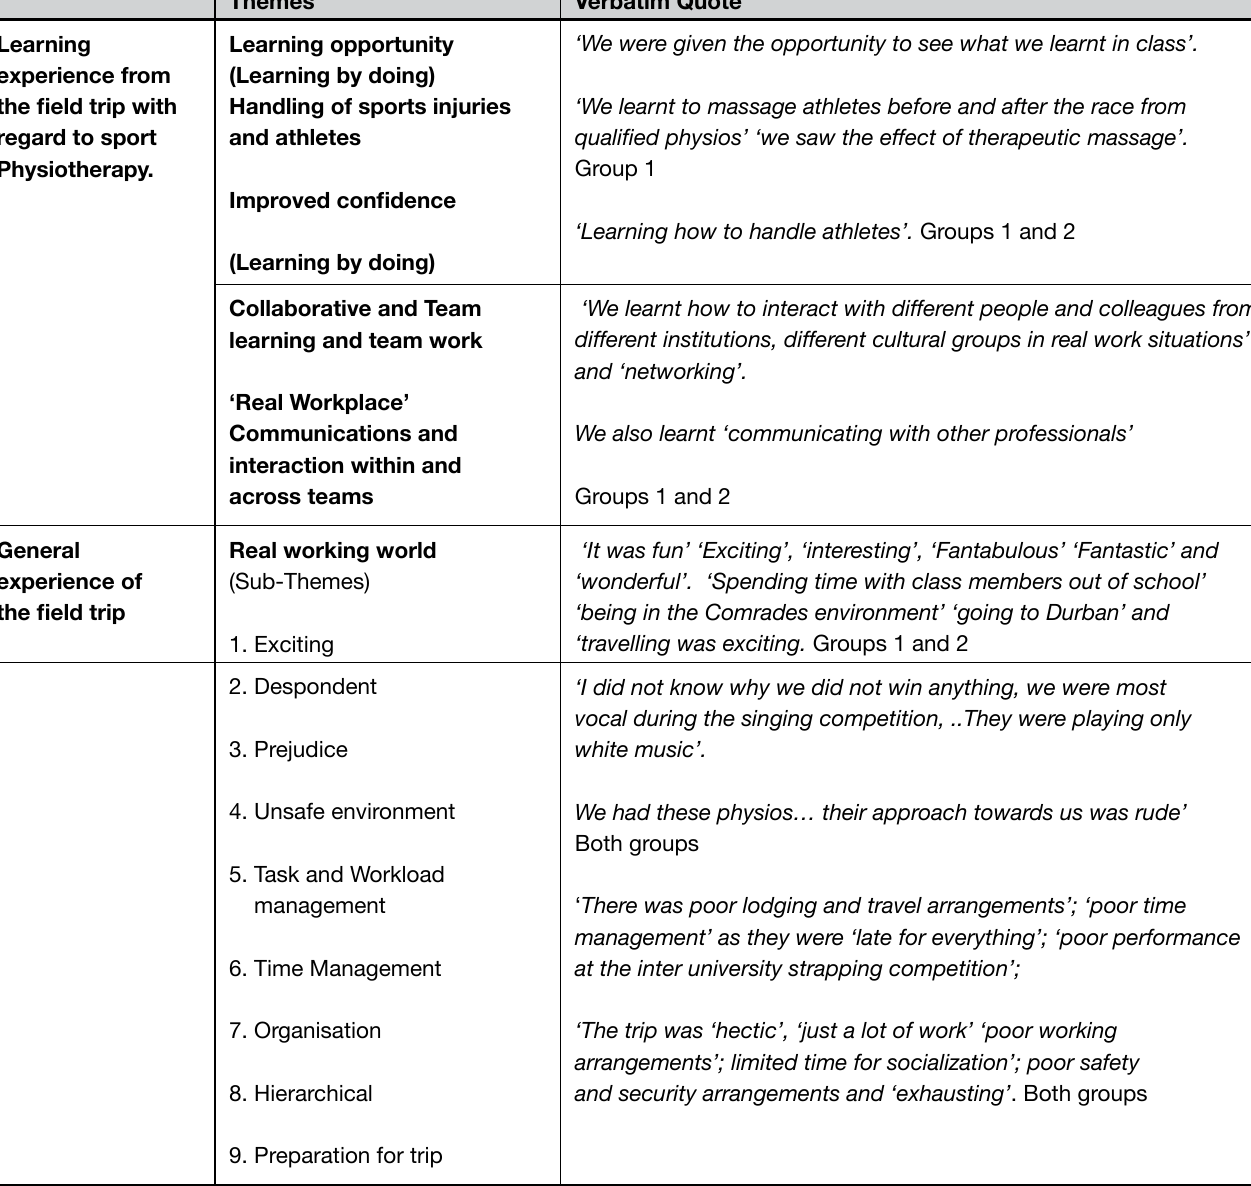
Table 1: Summary of themes generated from the focus group